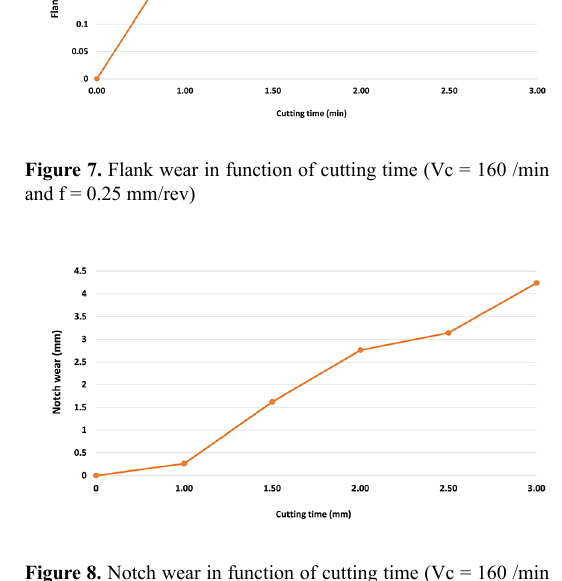
Figure 8. Notch wear in function of cutting time (Vc = 160 /min and f = 0.25 mm/rev)